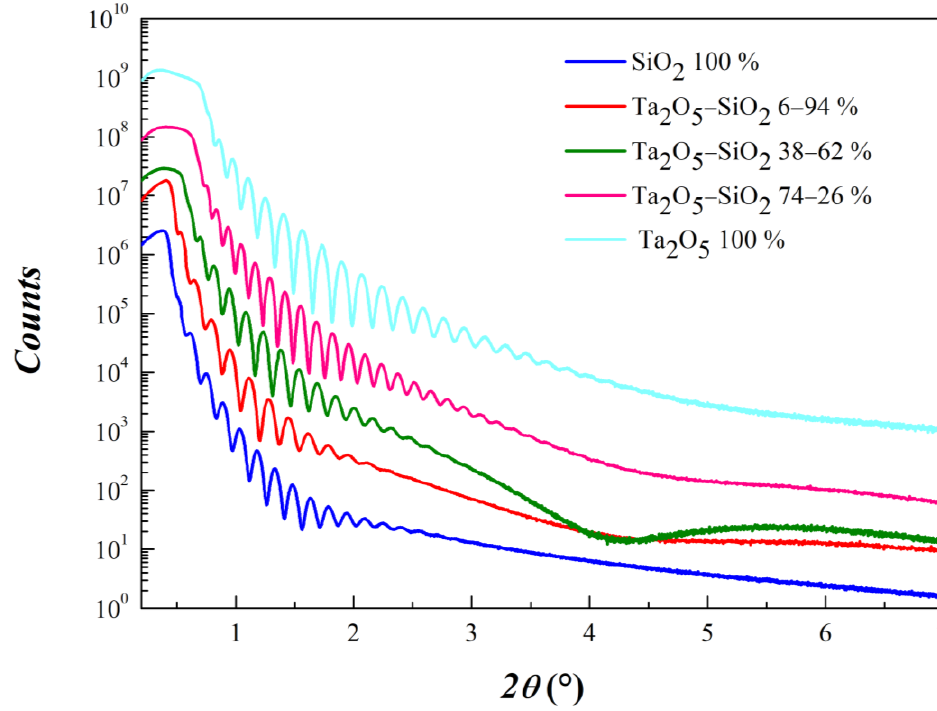
Figure 6. Comparison of XRR curves on Ta 2 O 5 /SiO 2 mixed oxide samples with different composi- tions obtained at Ar pressure equal to 2.5 × 10 −3 mbar. Ar flow was kept at 3.9 sccm.